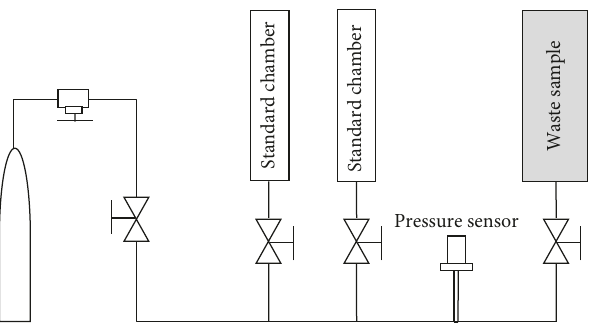
Figure 2: Schematic diagram of porosity measurement.